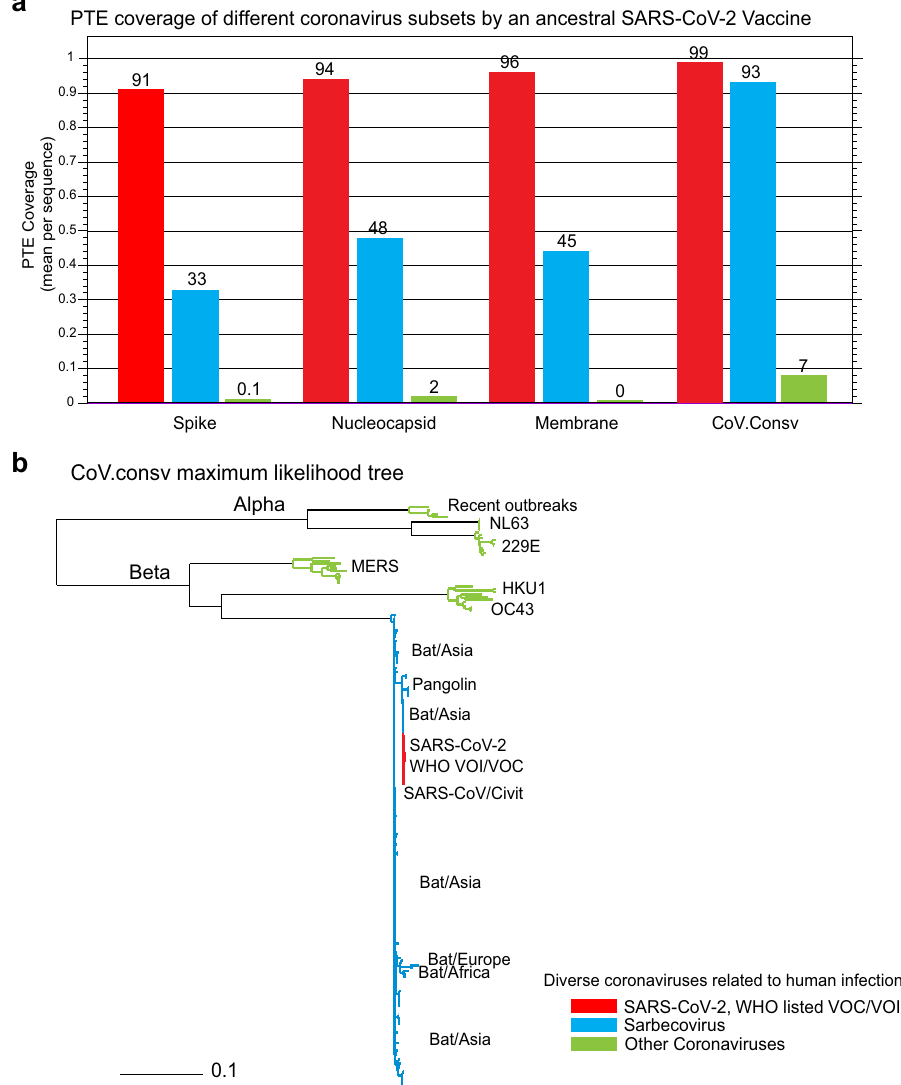
Fig. 2 The potential for cross-reactivity between T-cell responses to vaccines based on the S, N, M or the CoV.Consv proteins from a single SARS-CoV-2 Wuhan reference strain vaccine antigen. a The average fraction of PTEs (9-mers) shared exactly (PTE coverage) between the putative vaccine antigen and: (i) SARS-CoV-2 pandemic variants (red), (ii) diverse Sarbecoviruses (blue), and (iii) alpha- and betacoronavirses (green) related to those coronaviruses known to infect people, for the S, M, N and the CoV.Consv region. b A midpoint rooted phylogenetic tree based on an alignment of the CoV.Consv region using the sequences included in the three different groups used to explore PTE coverage, illustrating the phylogenetic basis of the far greater diversity challenge for vaccines posed by alpha and beta coronaviruses than for sarbecoviruses and